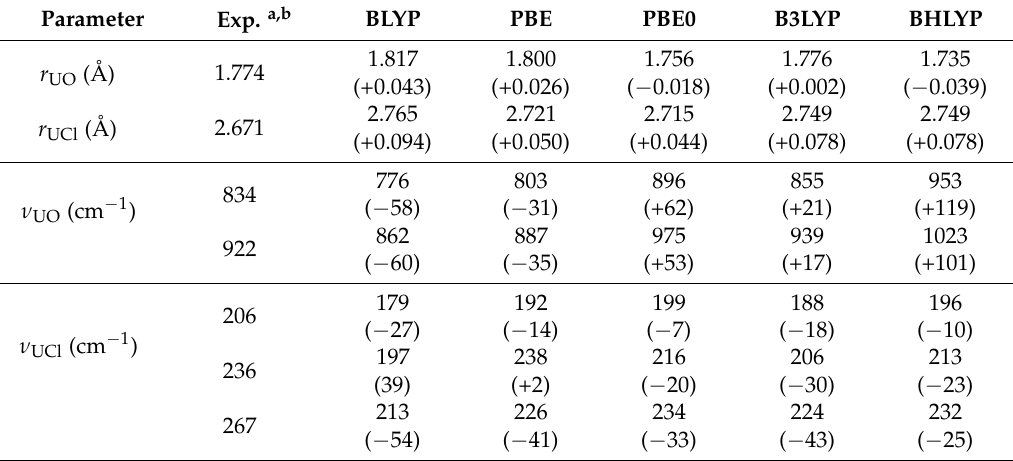
Table 1. Calculated structural and vibrational parameters of [UO 2 Cl 4 ] 2 − calculated with various exchange-correlation functionals. Values in parenthesis indicate deviations from experimental values.